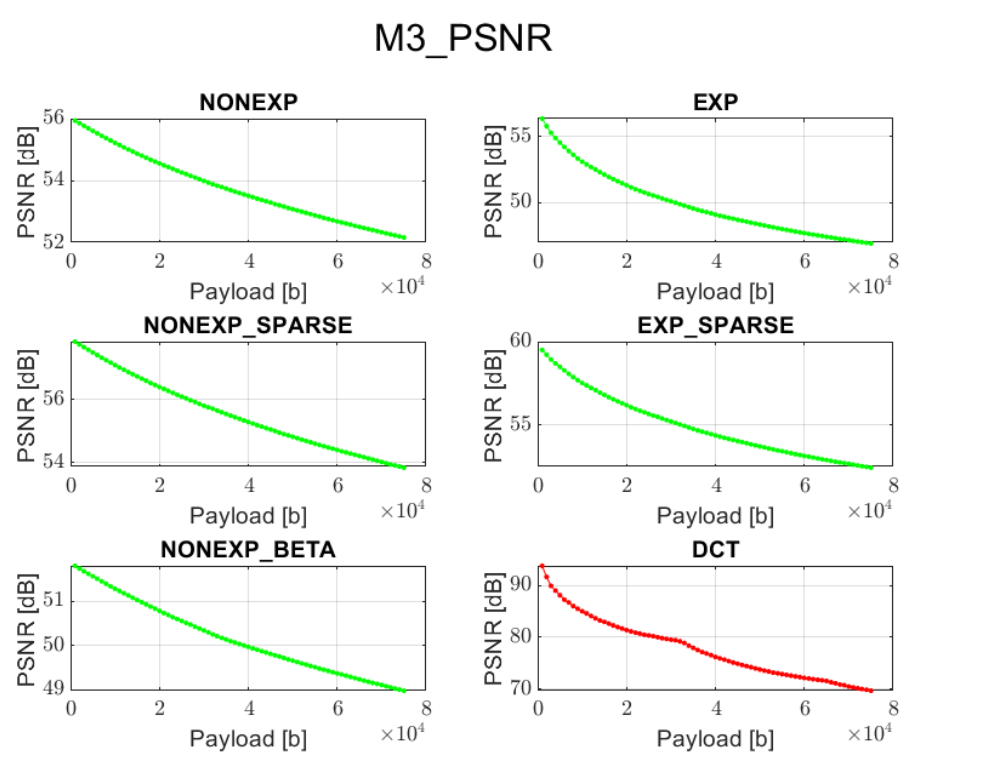
Figure 4. Relation between PSNR and embedded data size for method 3 and all transform types.